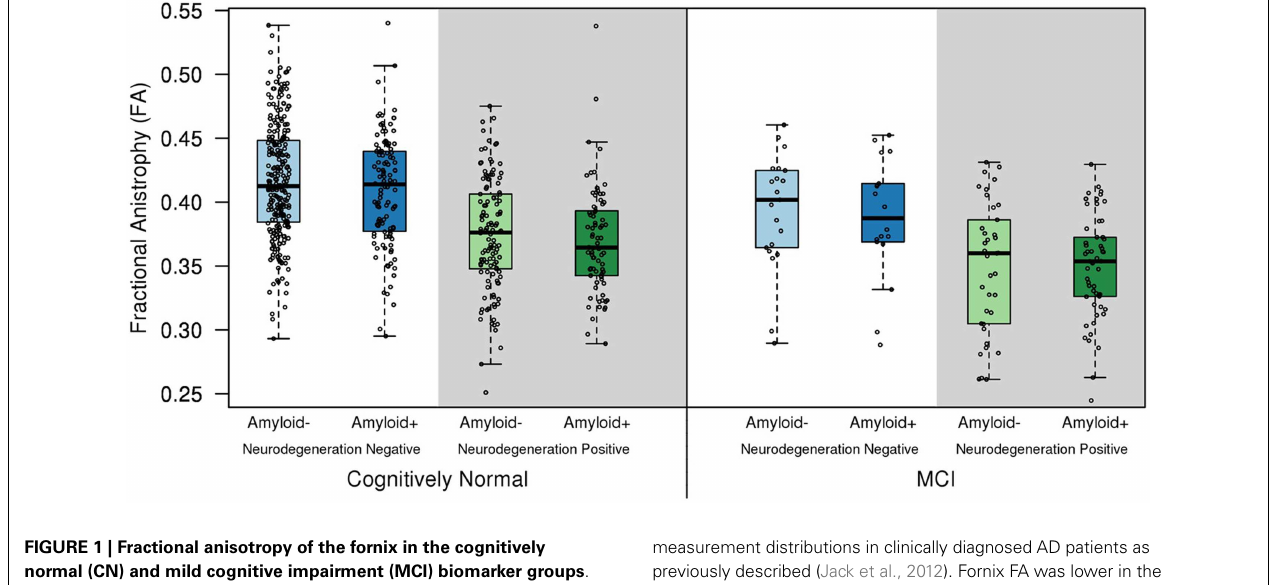
FIGURE 1 | Fractional anisotropy of the fornix in the cognitively normal (CN) and mild cognitive impairment (MCI) biomarker groups . Hippocampal atrophy on MRI and/or hypometabolism in the Alzheimer signature composite on FDG PET was used to classify subjects into the neurodegeneration-positive group, and high amyloid load on PET was used to classify subjects into the amyloid-positive group. Cut-points for amyloid positivity, hippocampal atrophy, and Alzheimer signature hypometabolism were determined from the 10th percentile of the